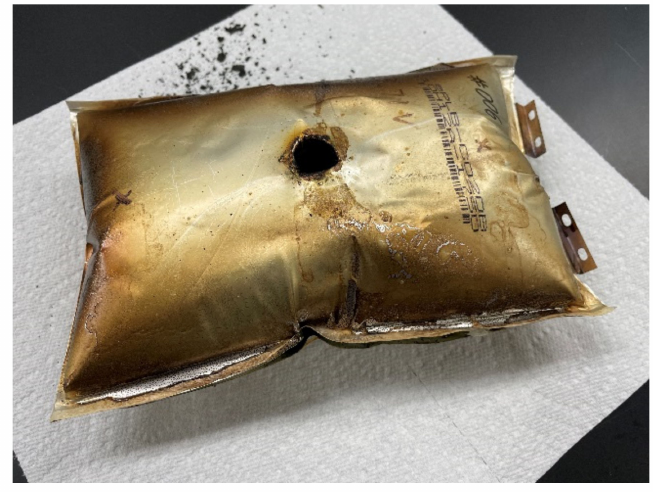
Figure 3. Battery cell after the combustion during the penetration